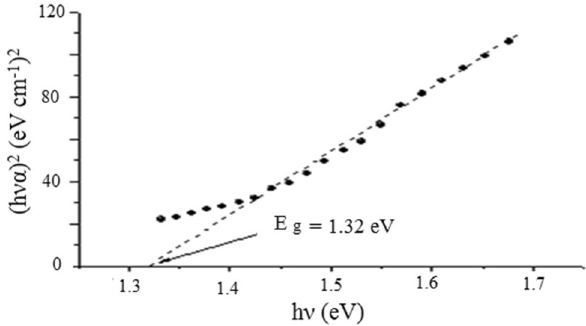
Fig. 2 The direct optical transition of CuFeO